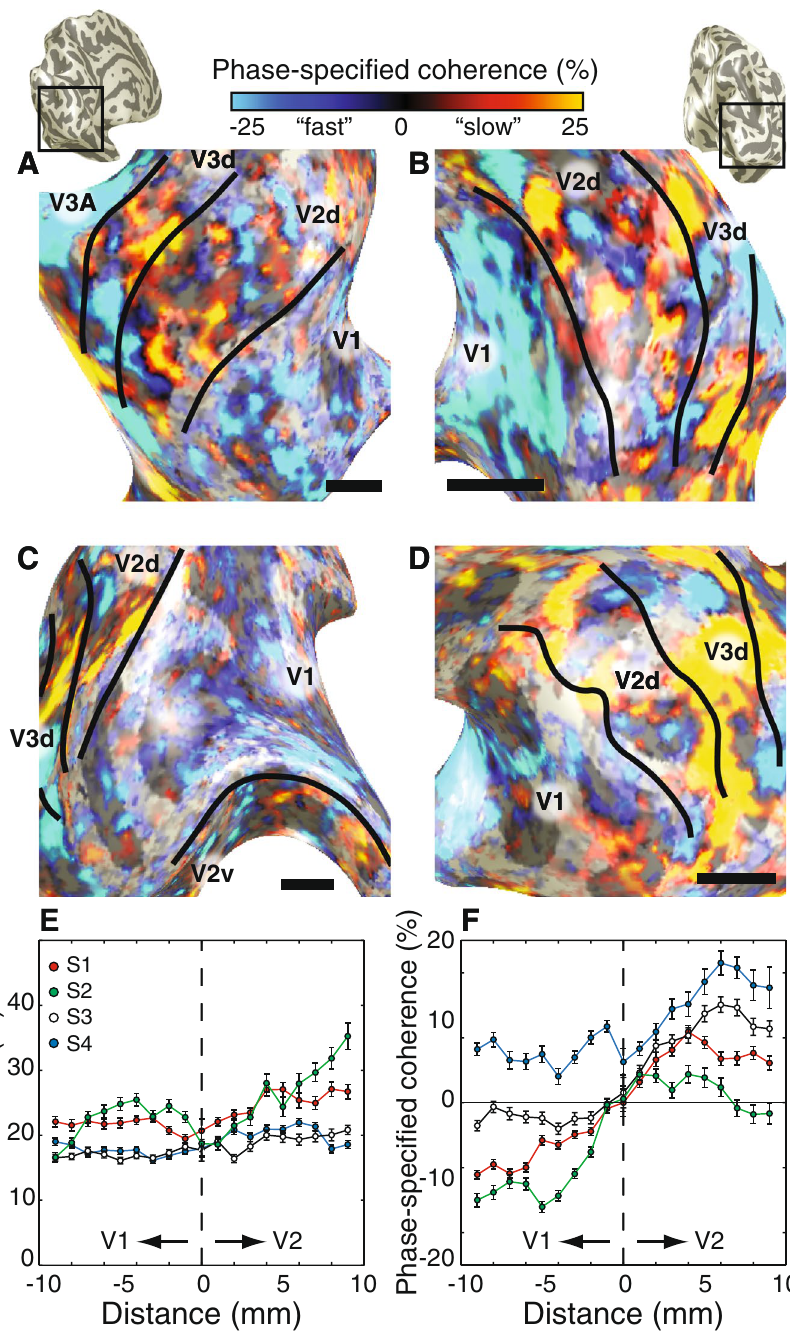
Figure 1. Functional delineation of V2 and V3 stripe-based subdivisions. Phase-specified coherence responses displayed on the left ( A,C ) and right ( B,D ) inflated cortical surfaces of three subjects (panels A,B: S3, panel C: S1; panel D: S2). The panels in A–D show the enlarged view of the dorsal occipital lobe with the identified V1/ V2d/V3d/V3A borders (top insets). The color bar indicates the phase-specified coherence values, indicating responses dominated by “fast” (7.5 Hz) or “slow” (1.5 Hz) temporal frequencies. Only phase-specified coherence values exceeding an absolute value of 15% are shown. The black horizontal line indicates 1 cm in each panel. The coherence and phase-specified coherence across the V1/V2 border is shown in panels E and F respectively. The coherence is a measure for overall response modulation irrespective of the relative response preference. The coherence values are similar across the border indicating a similar overall response to the stimulus ( E ). The phase- specified coherence also takes into account which temporal frequency drives the response. The phase-specified coherence changes across the V1/V2 border ( F ) demonstrating a distinct and systematic change in response properties along the V1/V2 border for all four subjects. The error bars reflect standard error of the